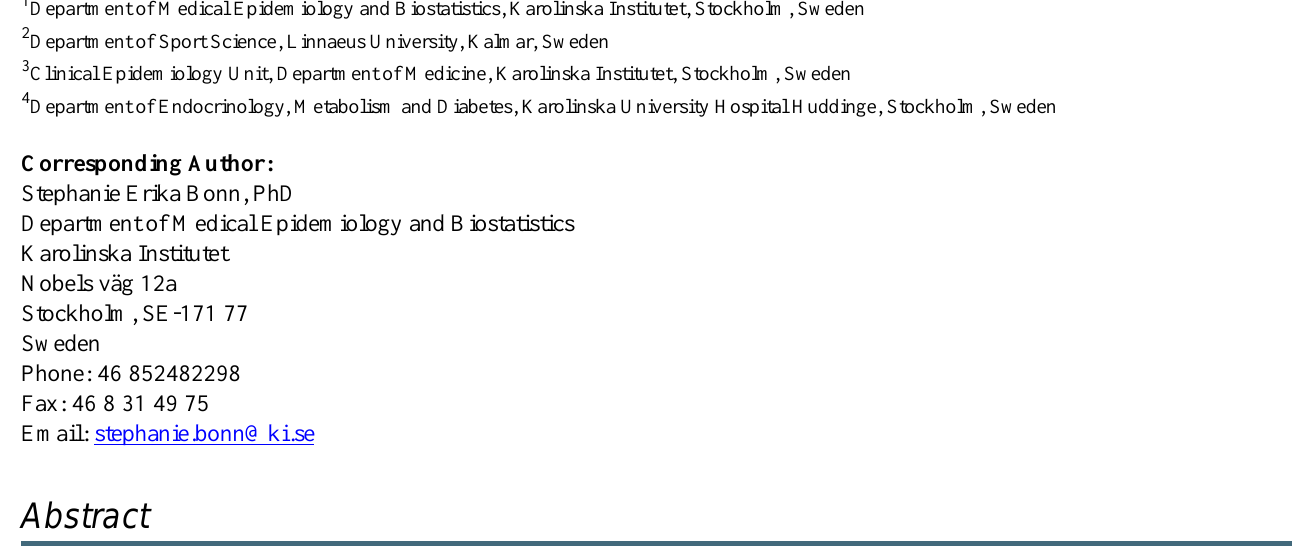
accelerometer; activity assessment; epidemiology; Internet; self report;